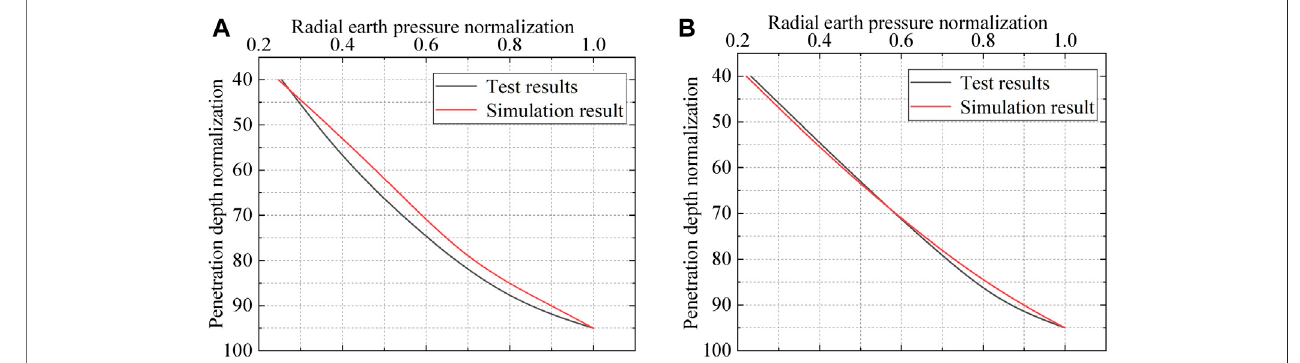
FIGURE 14 | Normalized comparison of experimental and simulated radial earth pressure. (A) M1 and TP1. (B) M2 and